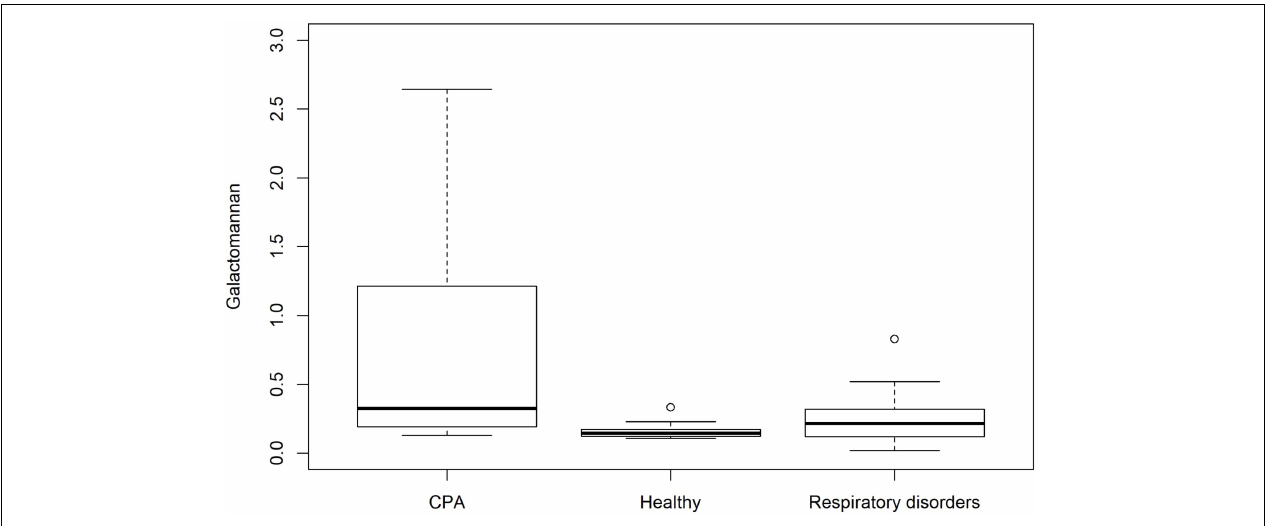
FIGURE 1 | Box plot showing the distribution of GM antigen levels for patients with CPA and controls including patients with respiratory disorders without CPA and healthy individuals.